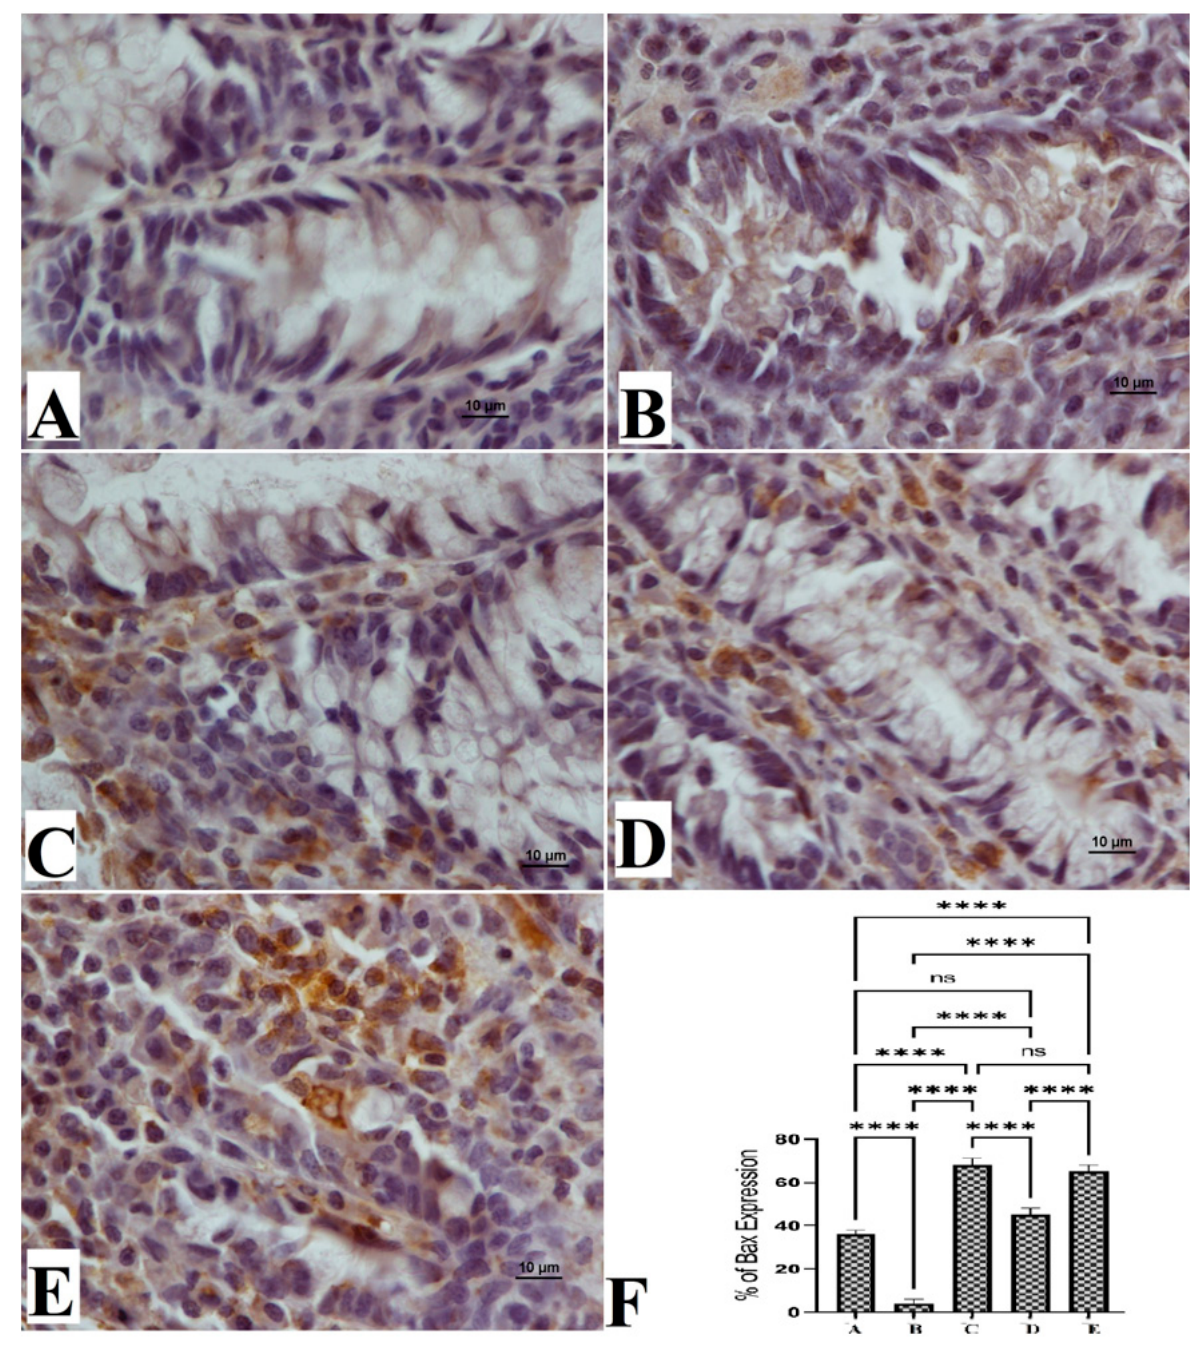
Figure 5. Histological views of colon tissue based on the Bax protein expression ( A – E ) and quanti- tative statistics ( F ) of Bax protein expression on colon tissue in induced foci in rats. Normal control rats ( A ) had normal mucosal structure and very weak expression of Bax protein ( F ). Colon cancer rats ( B ) had severe lesions in the mucosa and increased expression of Bax protein ( F ). Reference- treated rats (5-FU) ( C ) had mild mucosal colon tissue lesions and lower Bax protein expression ( F ). Rats treated with 200 mg/kg of OME ( D ) had moderate tissue damage and low Bax protein expres- sion ( F ). Rats treated with 400 mg/kg OME ( E ) had mild mucosal lesions of colon tissue and lower Bax protein expression compared to cancer controls ( F ). (Bax stain, magnification 100 × ). Values are shown as means ± SEM. ns, non-significant; ****, means significant at p <